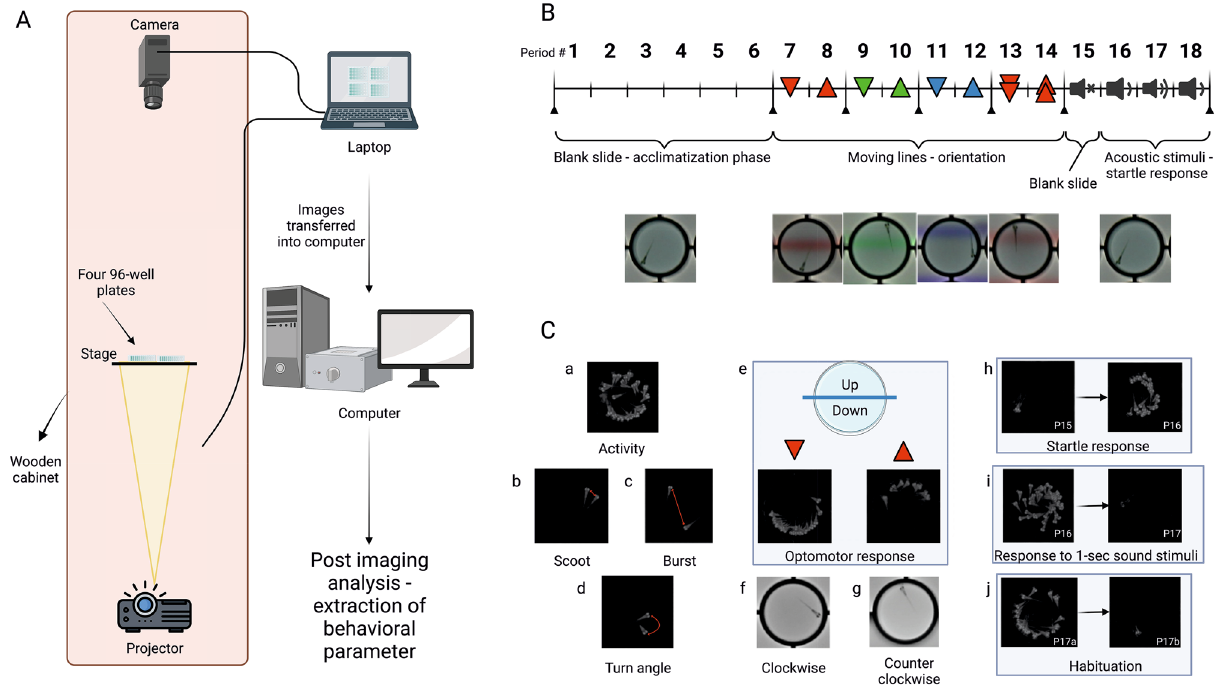
Figure 6. Experimental setup, timeline and description of behavioral variables: ( A ) experimental setup: the imaging setup in the laboratory consists of a projector attached to a laptop using PowerPoint for presenting visual/acoustic stimuli, a staging area (which can hold up to four 96-well plates), and a high-resolution overhead camera that clicks photos of 96-well plates at a set frequency (10 images per minute). The data is analyzed post-imaging using an automated python pipeline based on DeepLabCut. ( B ) Timeline for the presentation of visual and acoustic stimuli: during the first hour, a blank slide was presented, followed by moving lines of red, green, blue, and fast green in an up/down direction, followed by acoustic stimuli of 20-s and 1-s intervals. ( C ) 25 behavioral parameters were quantified for behavioral profiling: some example behaviors analyzed are shown in ( Ca ) activity during the first hour; ( Cb ) scoot slow/short swimming; ( Cc ) burst quick/long swimming; ( Cd ) absolute turn angle; ( Ce ) optomotor quick/long response—movement in the direction of moving lines; ( Cf ) clockwise; ( Cg ) counterclockwise swimming; ( Ch ) startle response—sudden activity in response to an auditory stimulus; ( Ci ) less excitability in response to 1-s interval sound stimulus and ( Cj ) habituation—decrease in activity upon presentation of the repeated sound